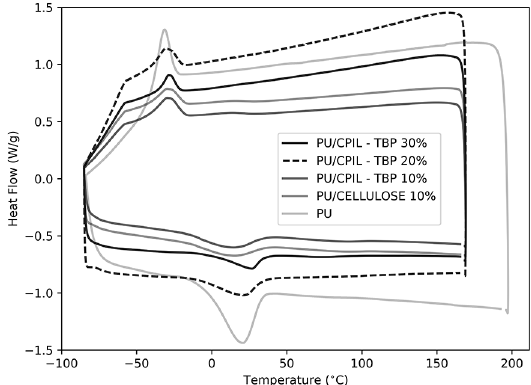
Figure 5. DSC thermograms obtained for PU and PU composites.